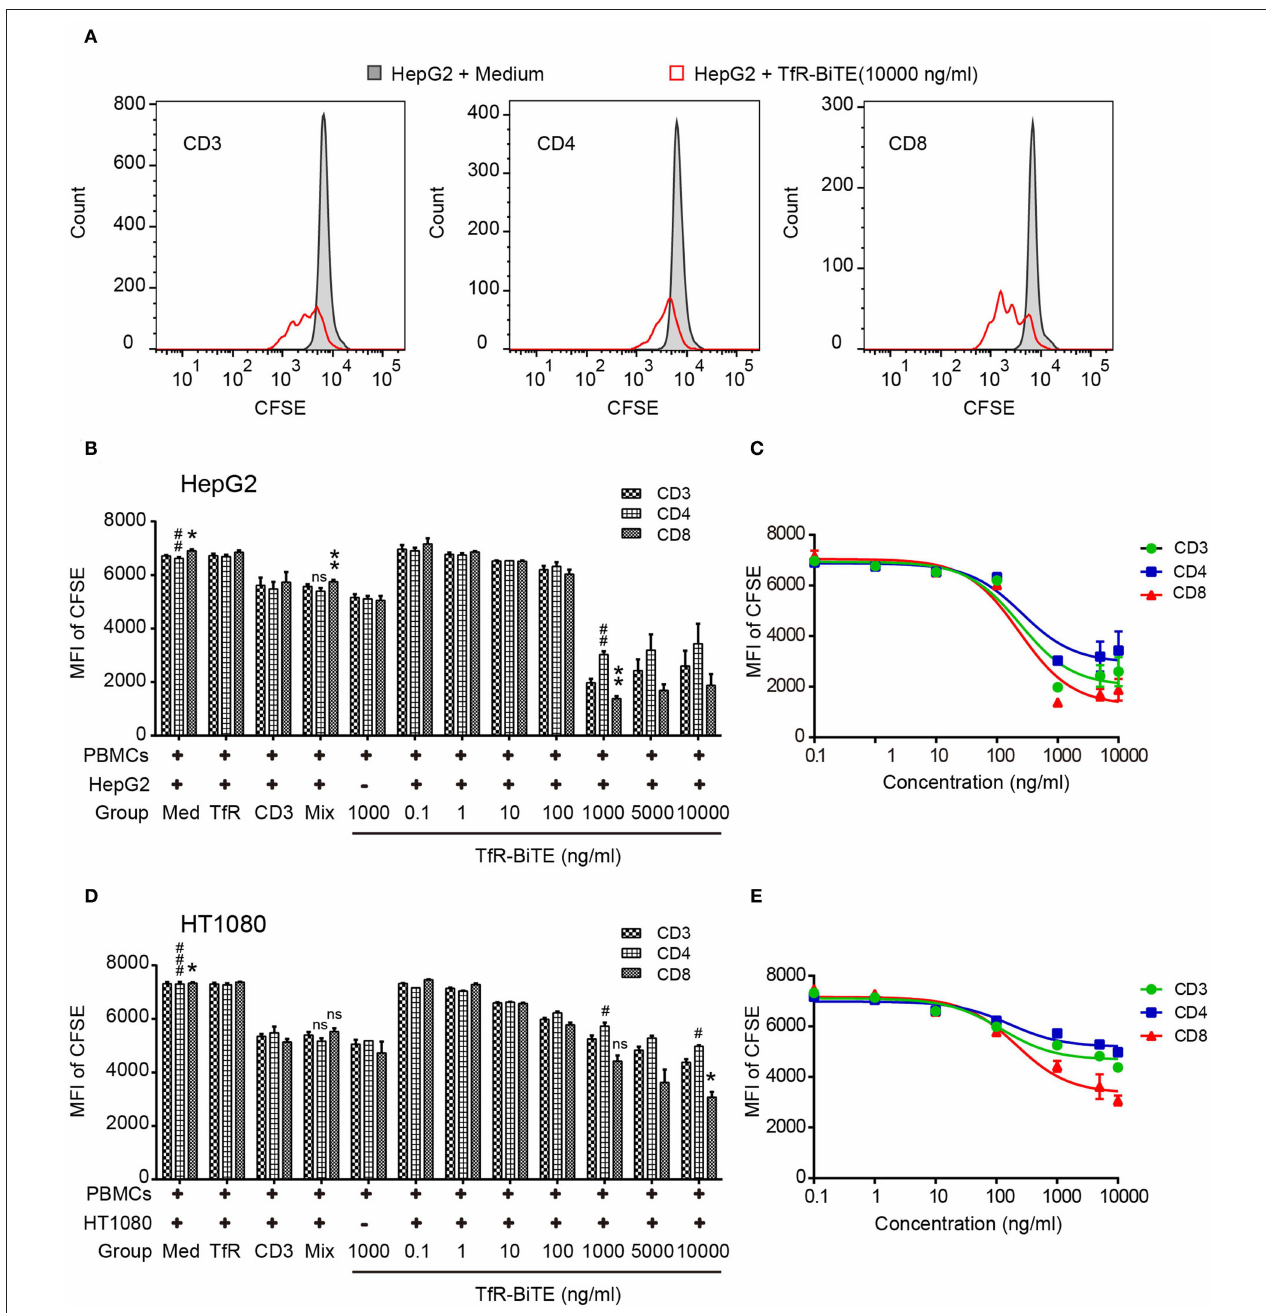
FIGURE 5 | TfR-BiTE promotes T-cell proliferation. HepG2 cells and CFSE-labeled PBMCs (E:T = 10:1) were incubated with indicated antibodies for 5 days. (A) Representative histograms of CFSE-labeled T-cell subsets measured by FCM. (B–E) Histogram and curve of CFSE-labeled T-cell subsets. The targets were HepG2 cells (B,C) or HT1080 cells (D,E) . The error bars indicate SD based on triplicates. The significance shown in the figure is compared with the TfR-BiTE 1,000ng/ml group without target cells. ns, not significant; * or # p < 0.05; ** or ## p < 0.01; ### p <